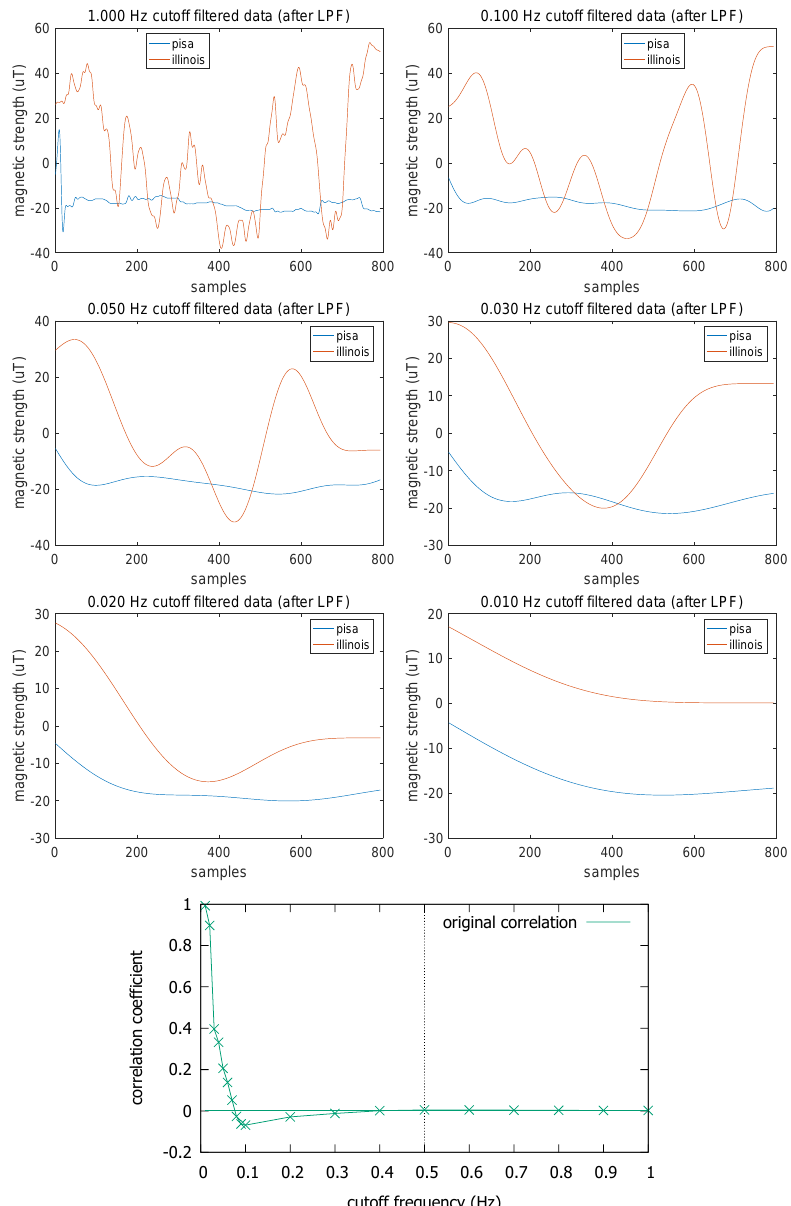
Figure 7. Overdoing the filtering increases the false positive rate: an example of Pisa-Illinois trace